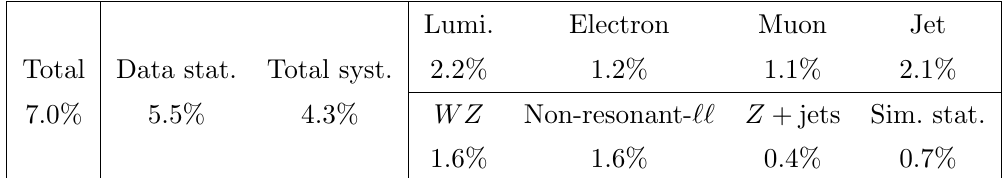
Table 7 . Relative contributions to the measured combined (cid:12)ducial cross-section from the main sources of uncertainty after the (cid:12)t procedure. The total uncertainty includes the data statistical and systematic components. For the systematic uncertainty, the individual sources of a similar nature are grouped together for simplicity. \Sim. stat." indicates the uncertainty source corresponding to the limited size of the simulation samples for the signal and background processes.